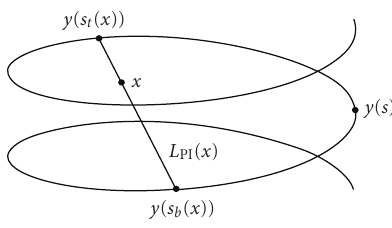
Figure 2: PI-line and PI parametric interval. A PI-line is a line seg- ment, the endpoints of which are separated by less than one turn in the spiral. Any x ∈ U belongs to one and only one PI-line, de- noted as L PI ( x ). Endpoints of L PI ( x ) are denoted as y ( s b ( x )) and y ( s x )), where s x ) and s x ) are angular parameters of the end- t ( b ( t ( points and s b ( x ) < s t ( x ). The interval I PI ( x ) : = [ s b ( x ), s t ( x )] is called PI parametric interval. The section of the spiral between y ( s b ( x )) and y ( s t ( x )) is called PI arc, denoted as C PI ( x